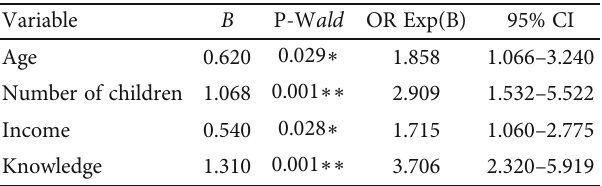
Table 4: Multivariate logistic regression analysis: associated factors of male participation in antenatal